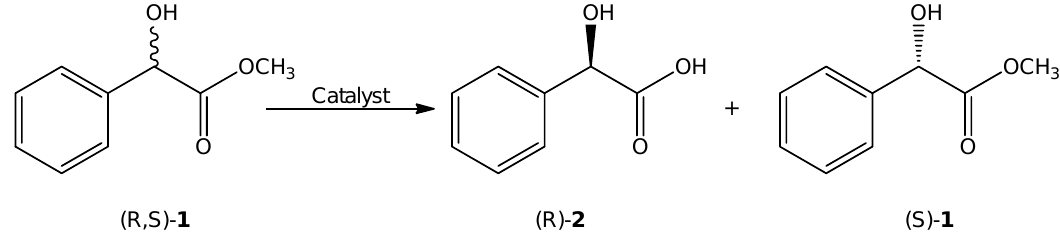
Scheme 1. Enzymatic kinetic resolution of rac -methyl mandelate ( 1 ). Table 2. Enzymatic kinetic resolution of rac -methyl mandelate ( 1 ) catalyzed by CALB EDA immobilized on different nanocarriers.